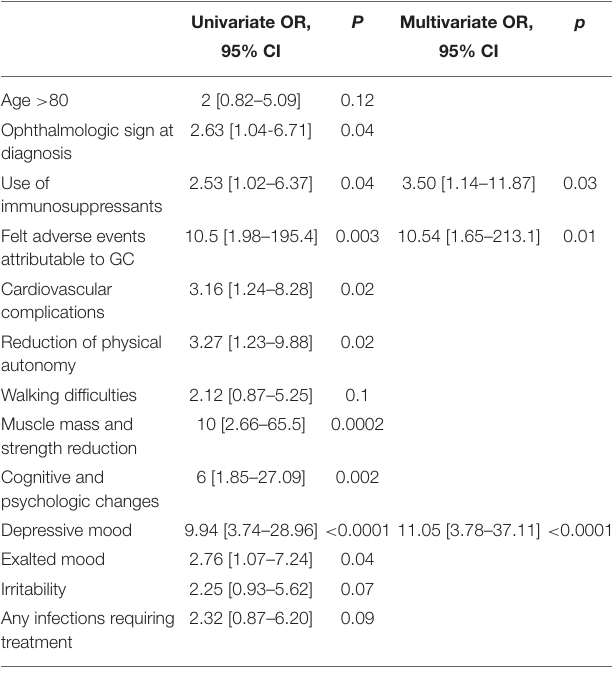
TABLE 4 | Factors associated with moderate-to-severe mental disability in univariate and multivariate models. Univariate OR, P Multivariate